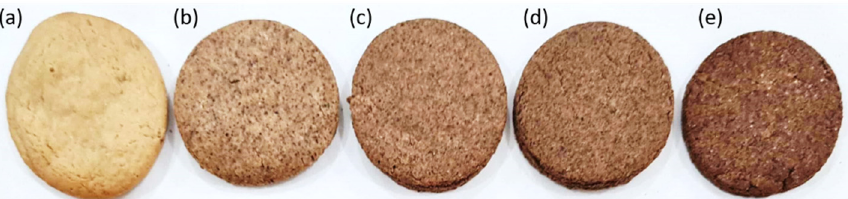
°Hue = Hue angle = arctg b*/a*. The same capital letters in the same row indicate differences that were not significant by the Duncan test ( p ≤ 0.05).